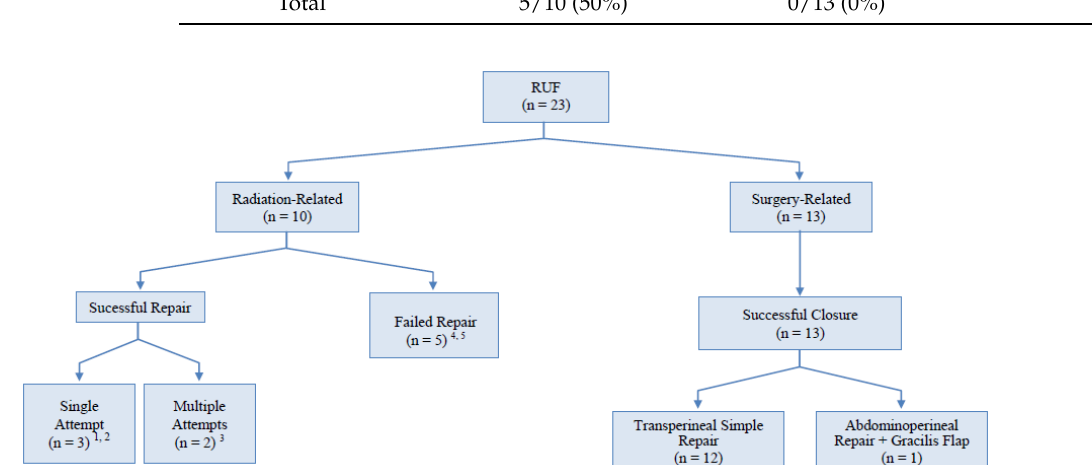
Table 2. Patients’ comorbidities and high -risk features.